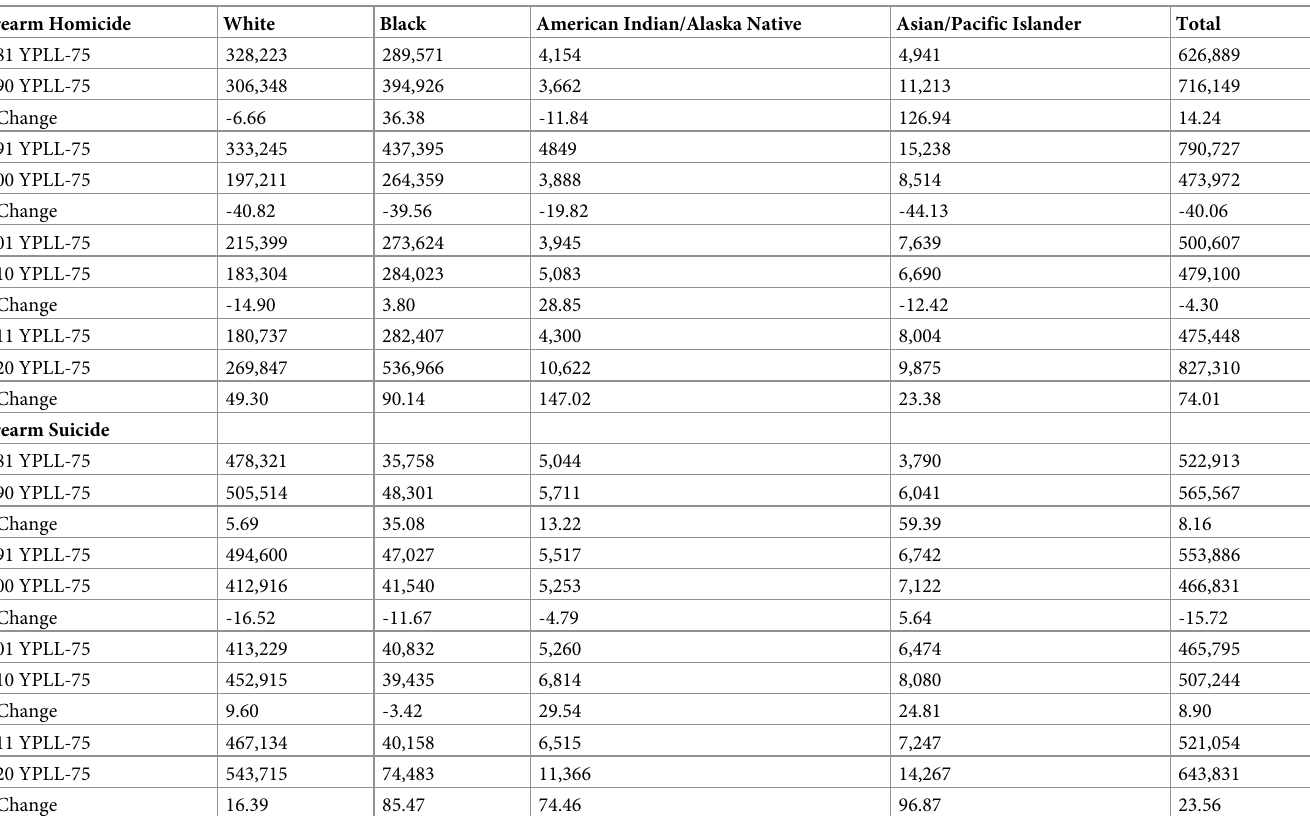
Table 1. Years of potential life lost under 75 (YPLL-75) and percent (%) change by firearm homicide and suicide deaths, 1981 to 2020 by 10-year interval periods. Firearm